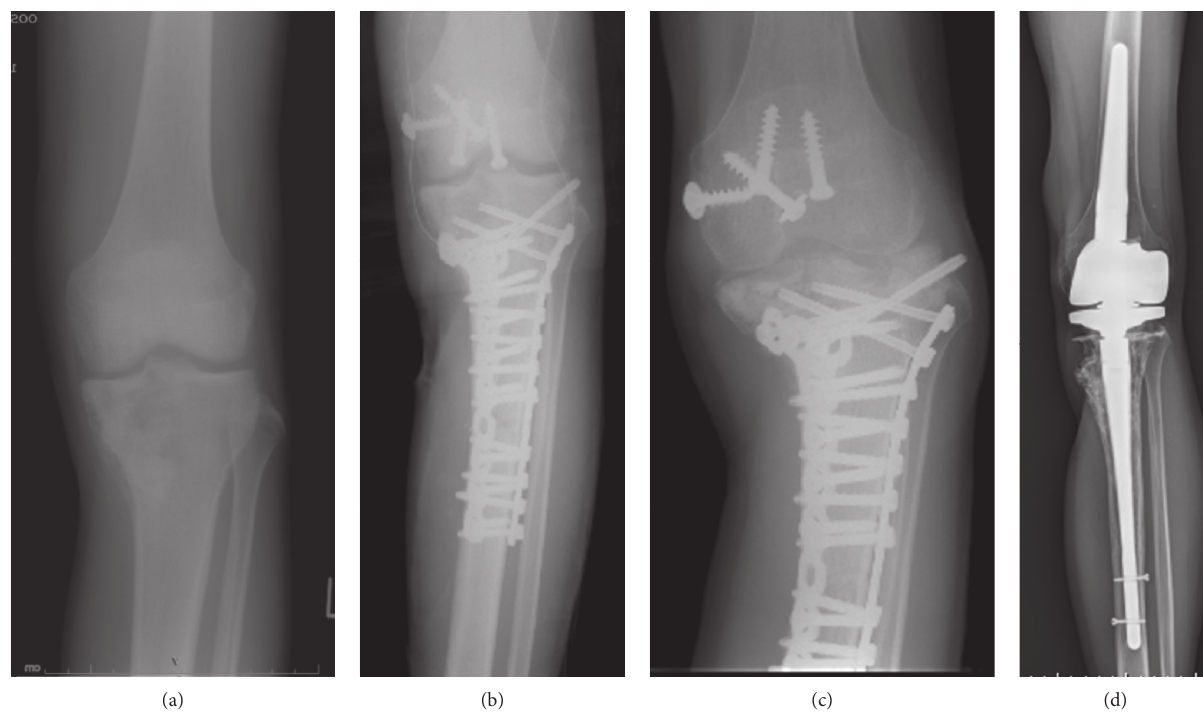
Figure 2: Case #27: 17-year-old male with osteosarcoma of the left proximal tibia. (a) Preoperative X-ray. (b) Immediately after treatment with osteoarticular extracorporeal irradiated autograft. (c) 16 months after operation, collapse of the autograft occurred and (d) reoperation with total knee arthroplasty composite with the remaining autograft.